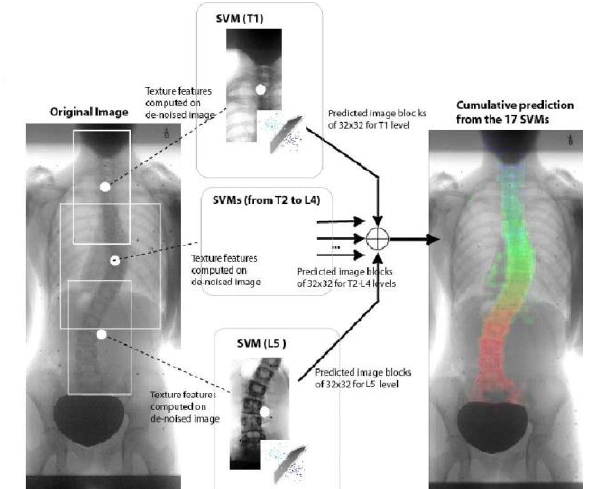
Figure 2. Block diagram of the segmentation algorithm. Each ROI is divided into image blocks and texture features are computed from each image block; (Source: Duong et al., 2010)